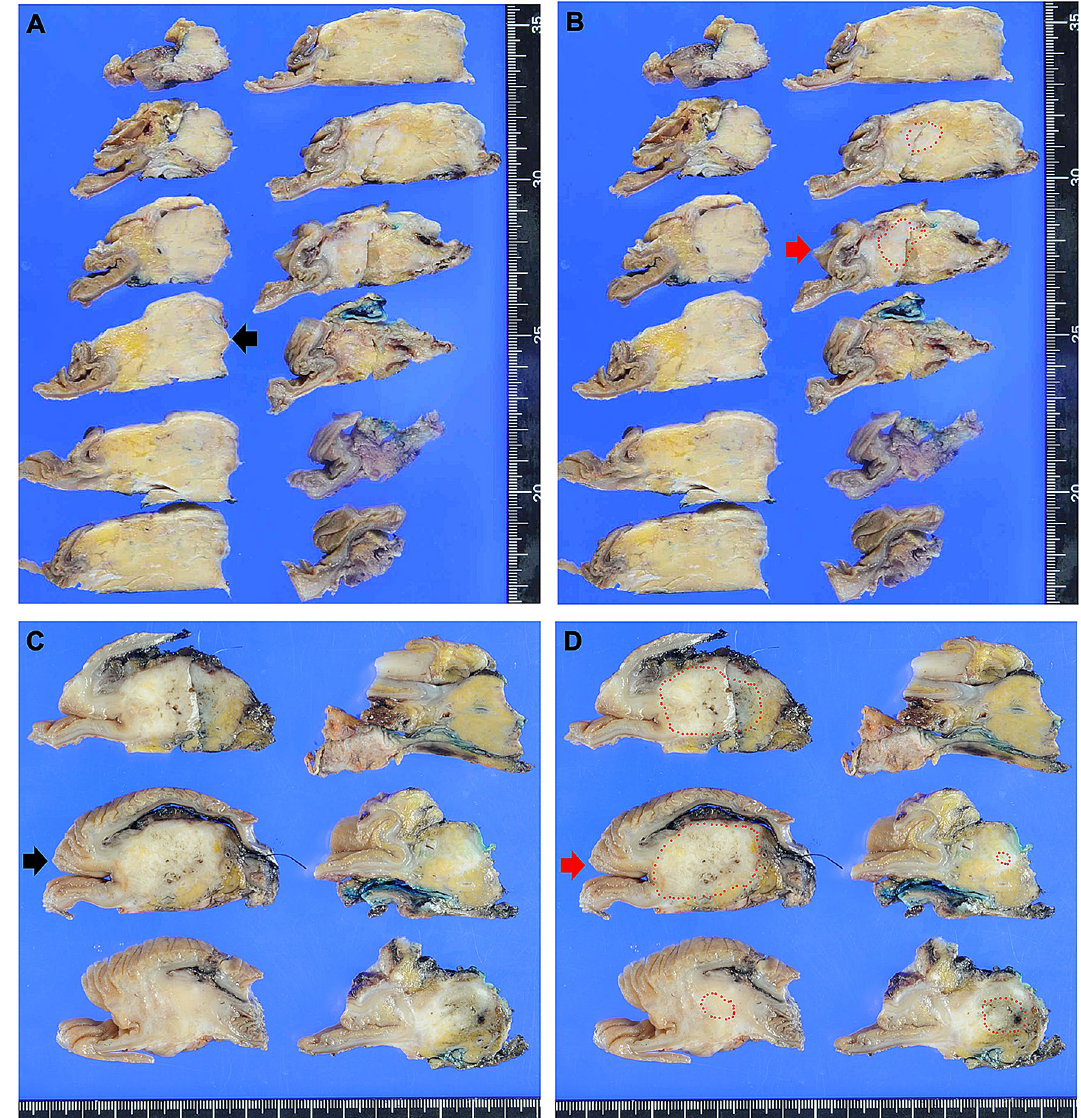
identify. The black arrows show the largest cancer area determined macroscopically, and the red arrows show the largest cancer area determined histologically. Circles with a red dotted line indicate the histologic cancer area.